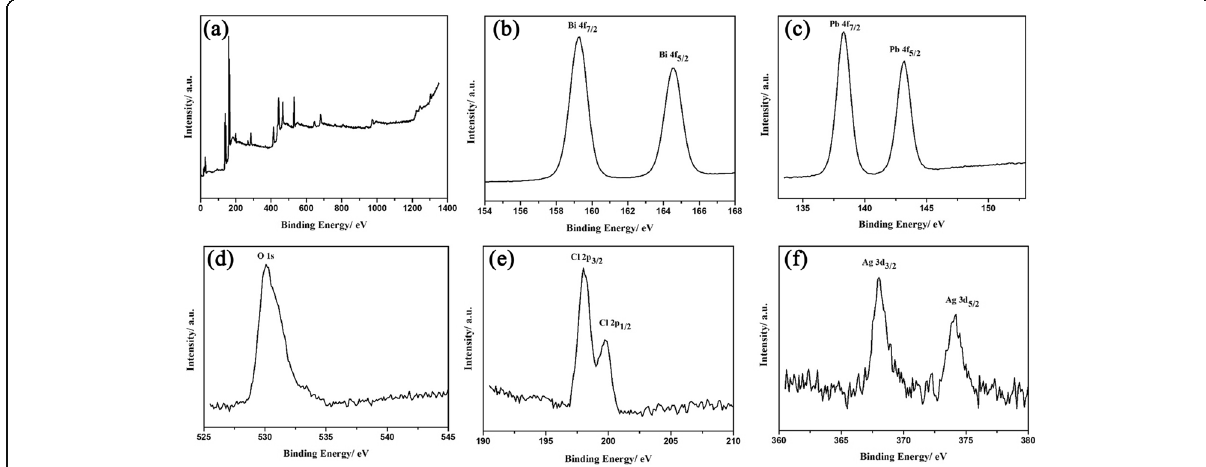
Fig. 4 The XPS spectra of Ag/BiPbO 2 Cl composites. a Survey, b Bi 4f, c Pb 4f, d O 1s, e Cl 2p, and f Ag 3d